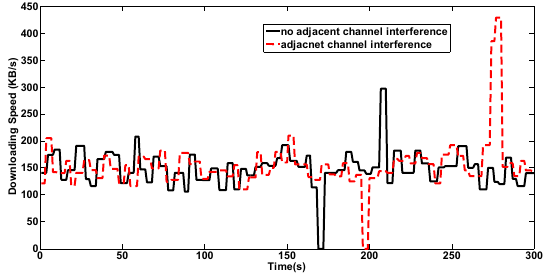
Figure 15. Evaluation of network service on the target public